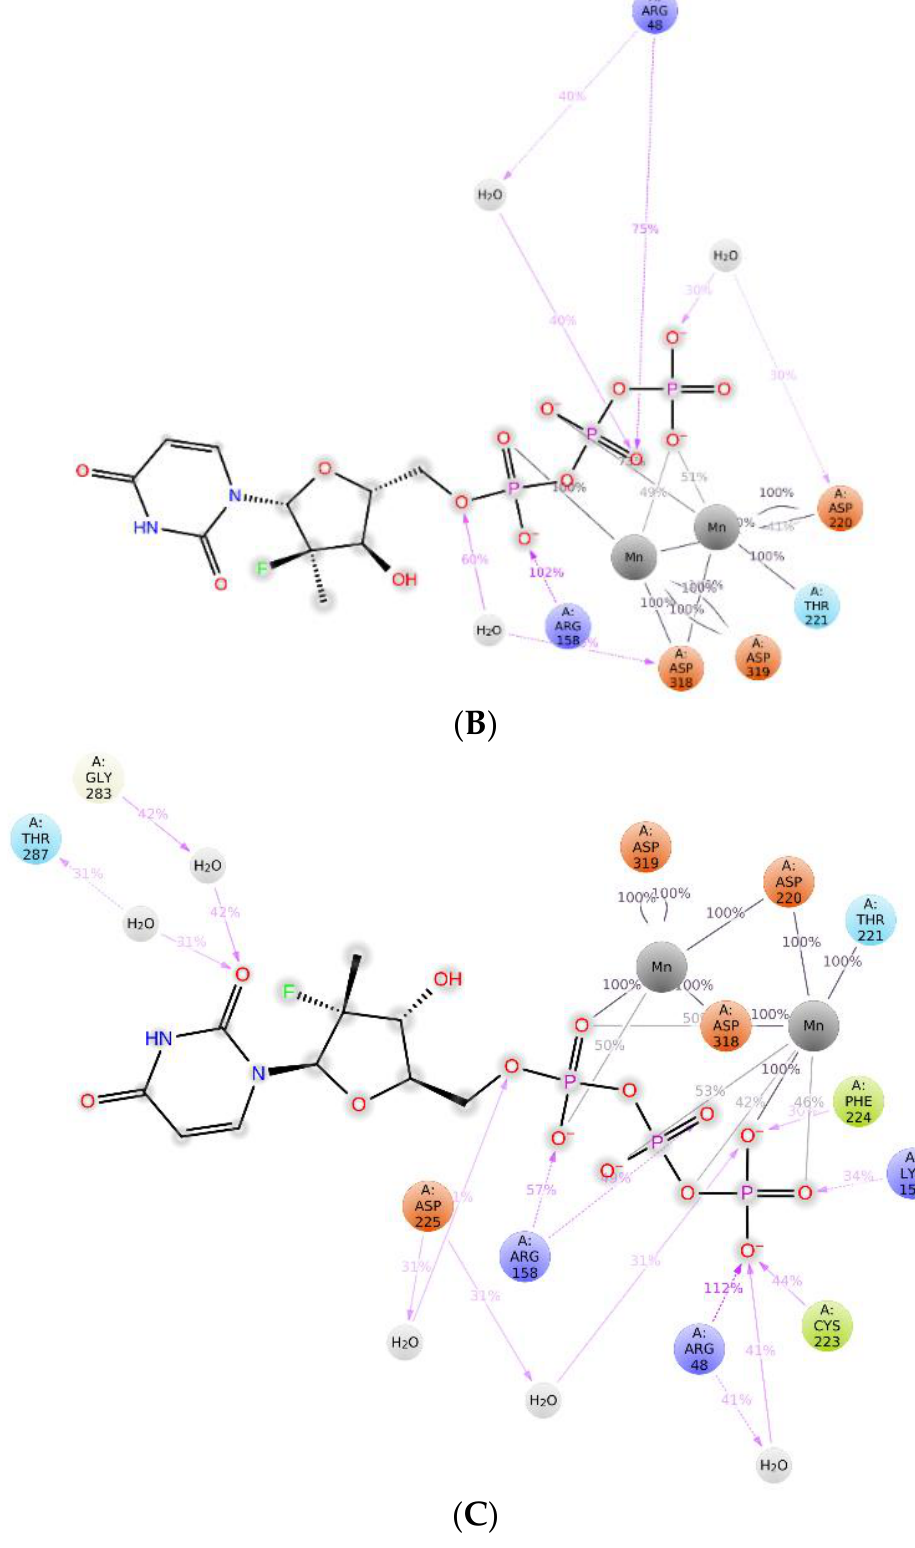
Figure 3. The 2D Protein–Ligand Interaction Diagrams lasting more than 20% of the MDS ( A ) WT-GS-461203; ( B ) T179A-GS-461203; ( C ) M289L-GS-461203 recorded during MD simulations.